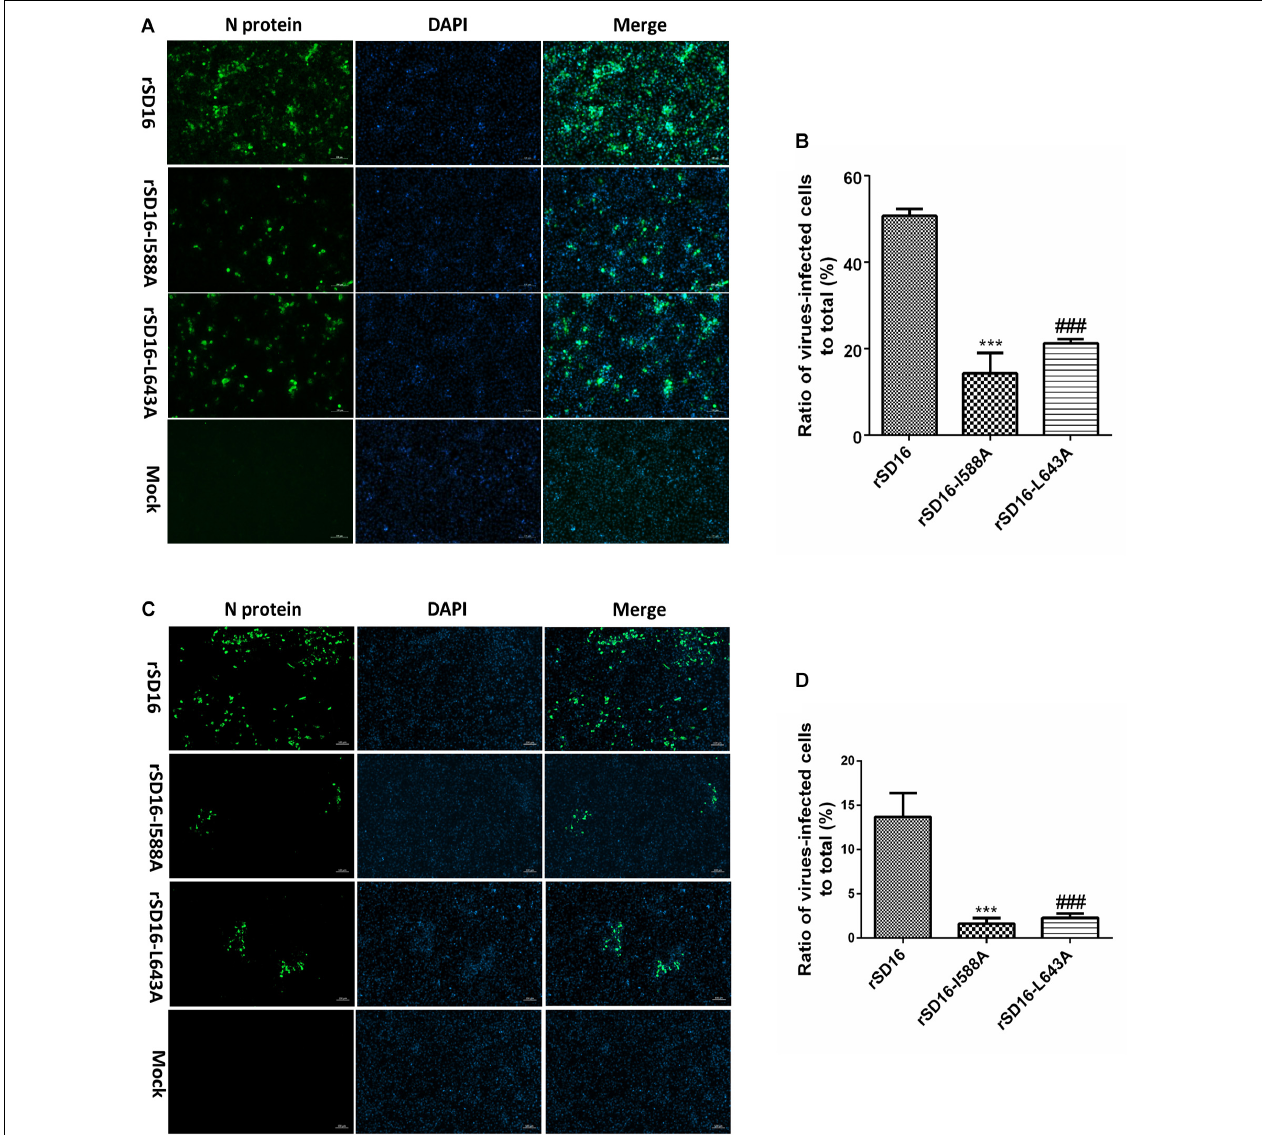
FIGURE 8 | Recombinant PRRSV viruses bearing mutations of residues 588 and 643 of Nsp9 impaired PRRSV replication in vitro . MARC-145 Cells (A) and CRL-2843-CD163 cells (C) were infected with mutated viruses or wild type rSD16 (0.1 MOI). IFA was performed at 48 hpi with the monoclonal antibody recognized PRRSV-N protein (Clone No. 6D10) and visualized by FITC-conjugated goat anti-mouse IgG. Overlay images were visualized for cell nuclei (blue) and N protein (green). The scale bars are 100 µ m. (B,D) The ratio of virus-infected cells/total cells calculated using Image J software. Asterisk (*) indicates a significant difference between rSD16 and rSD16-I588A (*** p < 0.001). Pound ( # ) shows a significant difference between rSD16 and rSD16-L643A (### p <